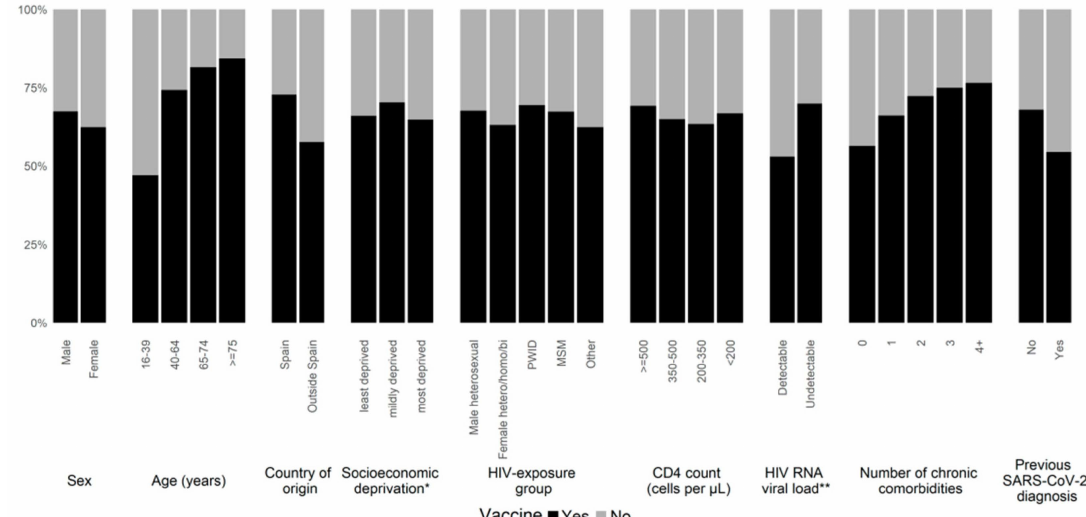
Figure 2. SARS-CoV-2 vaccination uptake according to various sociodemographic and clinical groups in the PISCIS cohort of people living with HIV (27 December 2020–11 July 2021). Ab- breviations: SARS-CoV-2, severe acute respiratory syndrome coronavirus 2; PWID, people who inject drugs; MSM, men who have sex with men; * According to the socioeconomic deprivation level index of the Catalan government based on the health area of residence. ** plasma HIV-RNA undetectable: ≤ 50